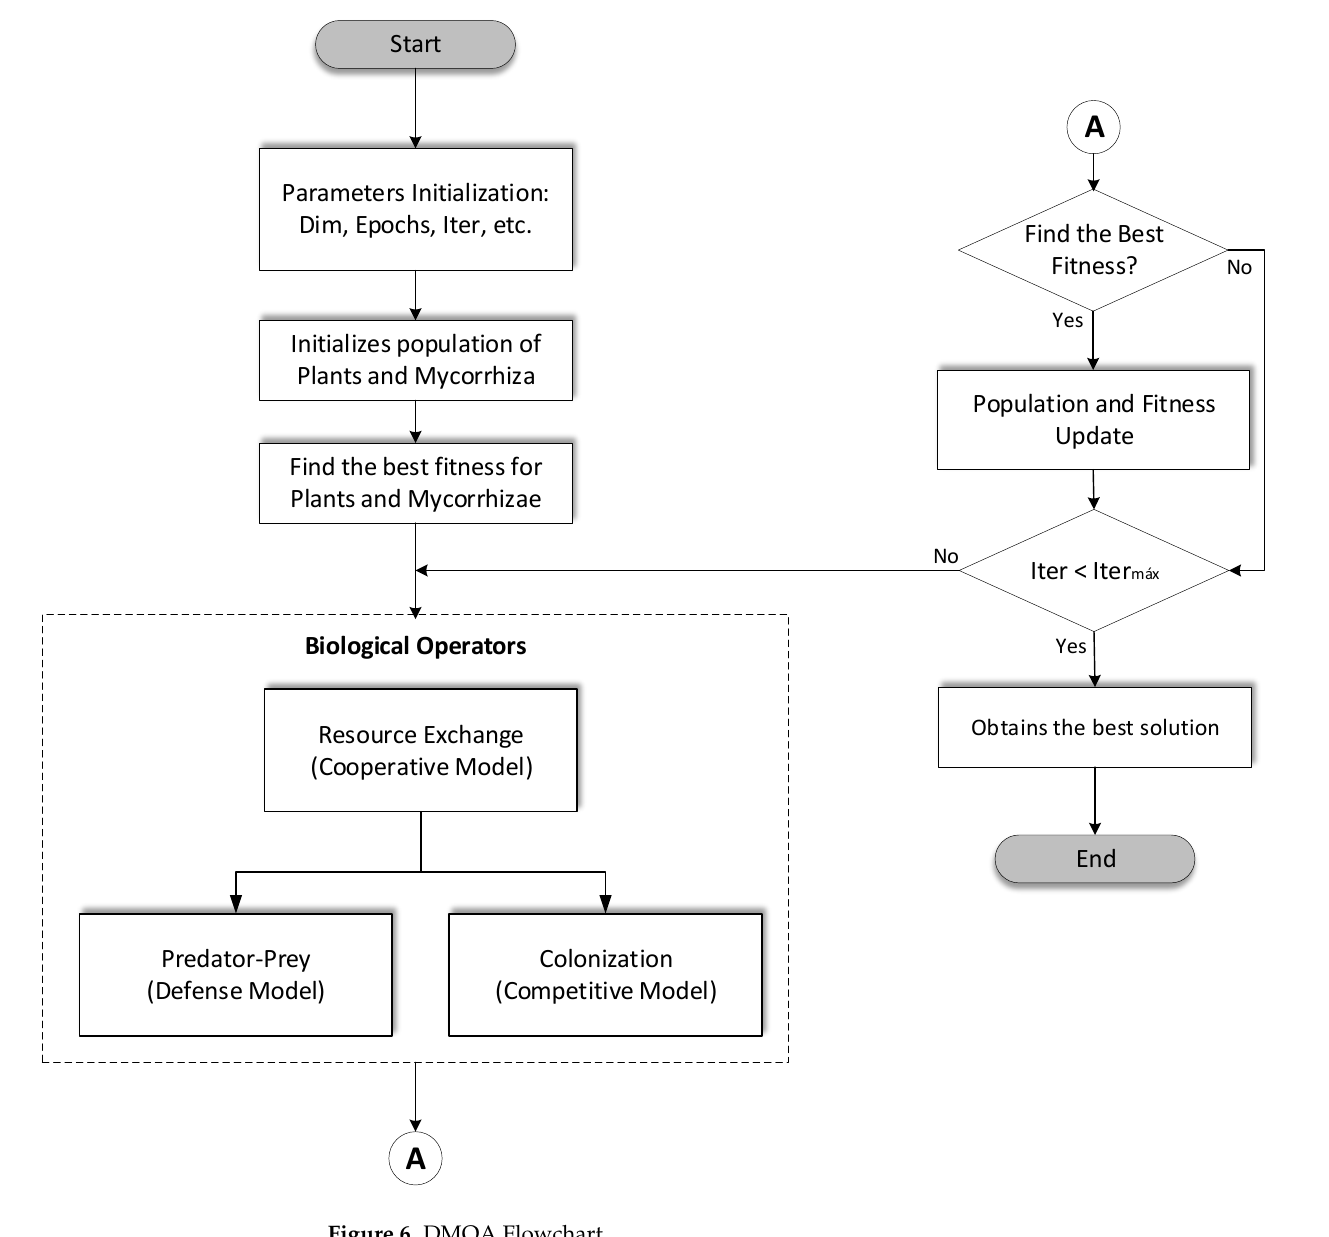
Figure 6. DMOA Flowchart.